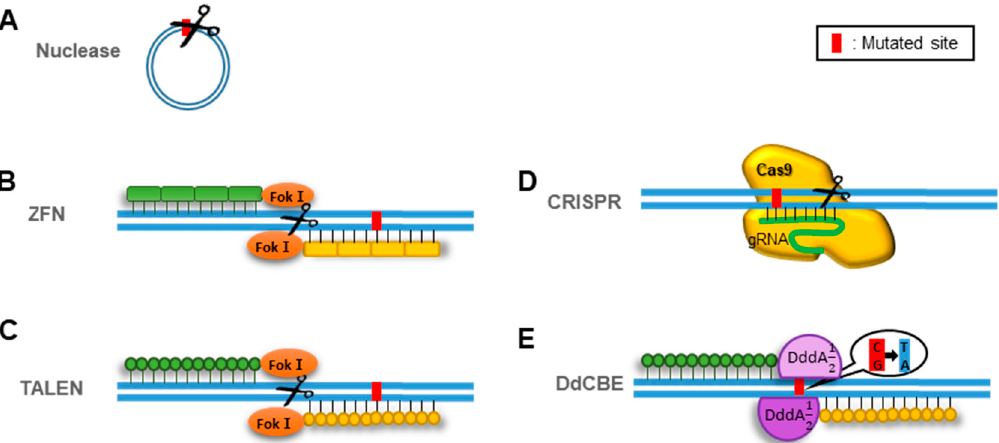
Figure 1. Methods of reducing mtDNAs harboring mutations to treat misregulation of mitochondrial gene expression. ( A ) Nuclease cleaves the target mutated sites. ( B ) ZFN: constructed by fusing the Fok I endonuclease with an array of zinc fingers, each having a recognition ability for a three-base DNA sequence. ( C ) TALEN: constructed by fusing Fok I with single base-recognizing domains, TALEs. ( D ) CRISPR: gRNA recognizes the mutation-including domain, and Cas9 cleaves mtDNA around the gRNA-bound site. ( E ) DdCBE: TALEs recognize the periphery of the mutation, and the two parts of DddA were fused to form the whole DddA toxin that can convert cytosine to